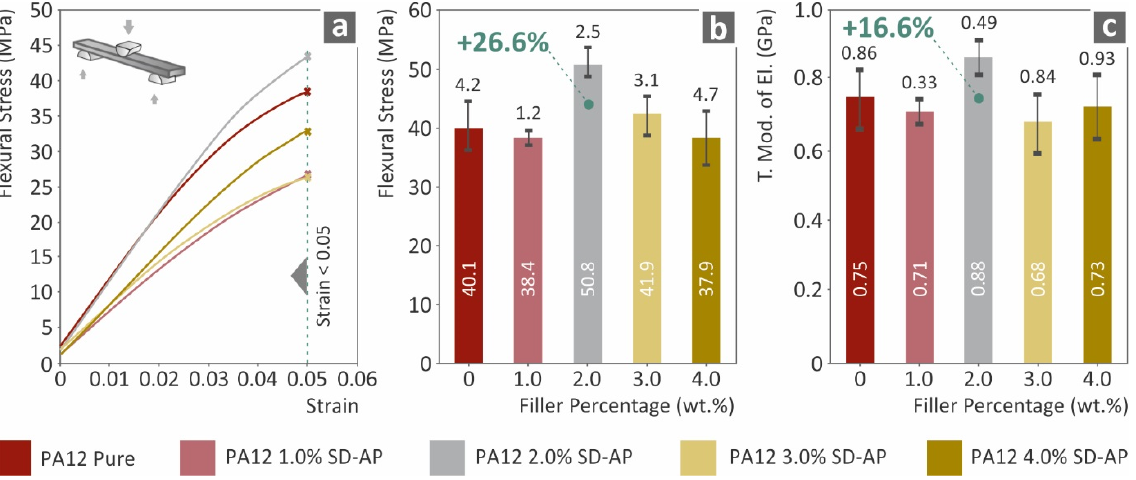
Figure 4. Flexural test results: ( a ) typical flexural stress (MPa) to strain (mm/mm); ( b ) flexural stress at highest tested 5.0% strain to filler loading; ( c ) flexural modulus of elasticity to filler ratio.